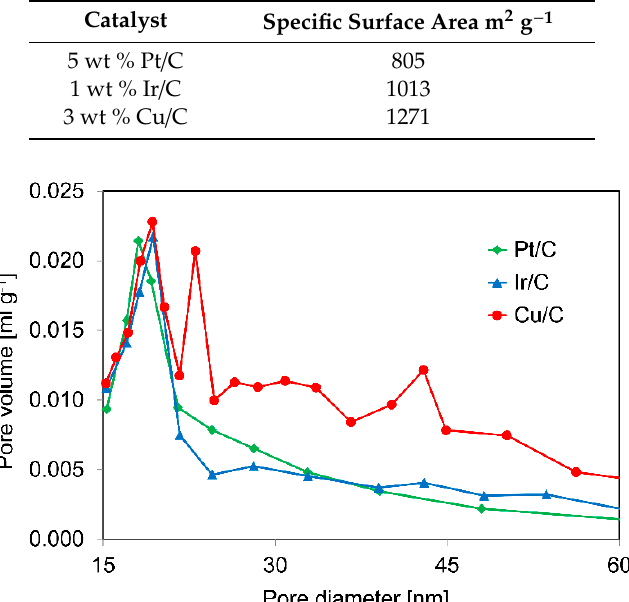
Table 1. Specific surface areas of the di ff erent C-supported catalysts.